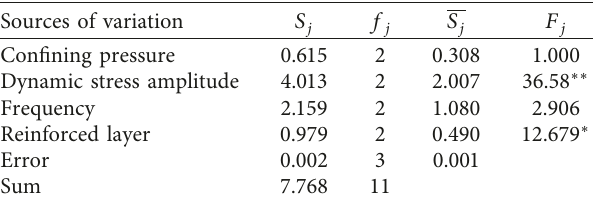
Table 7: Results of variance analysis of orthogonal design of experiment. Sources of variation S j